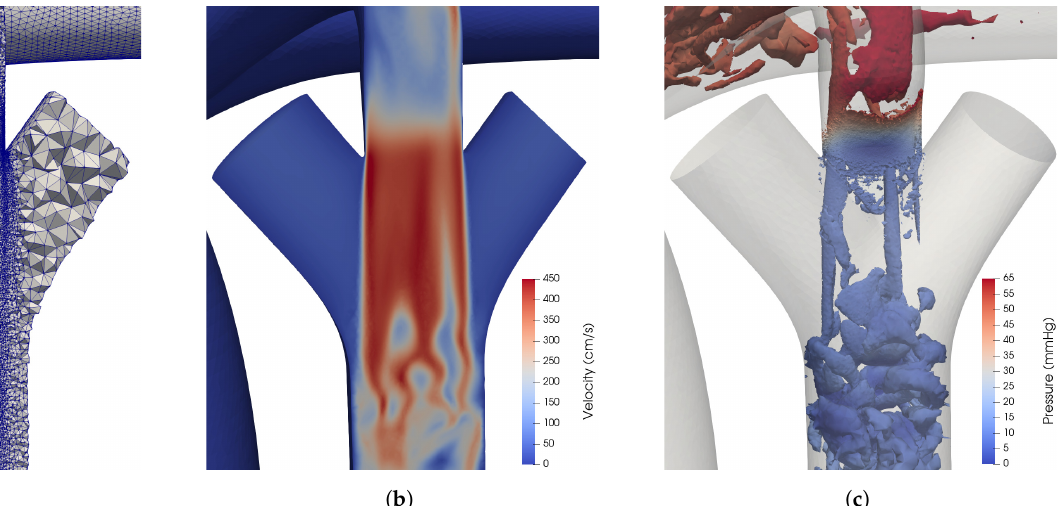
Figure 2. ( a ) Tetrahedral mesh cross section, ( b ) velocity field, and ( c ) Q-criterion contour at the shunt-SVC junction for the ABG simulation with a nozzle size of 3 mm 2 and PVR of 4.7 Wood units-m 2 at end